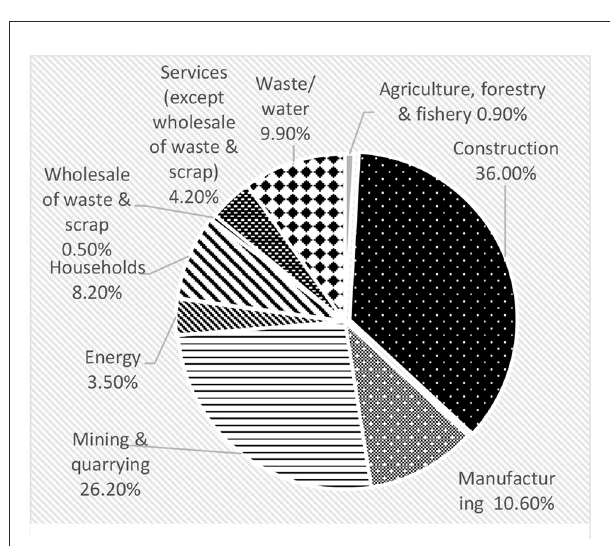
FIGURE6 Waste generation by economic activity and households EU-27, 2018. Source: Eurostat (online data code: env_wasgen).